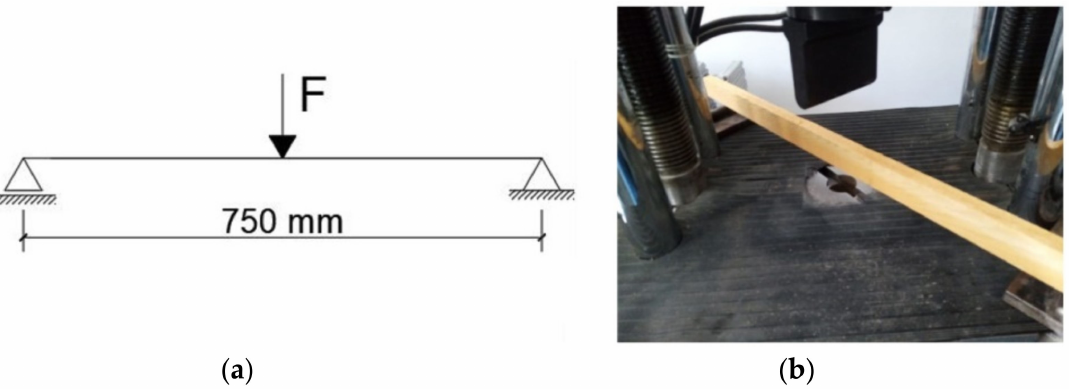
Figure 5. Laboratory three-point bending test setup: ( a ) static scheme of three-point bending test, ( b ) test setup on plain wooden